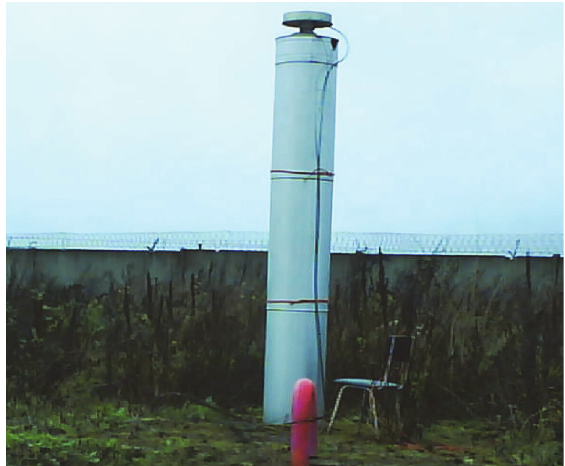
Fig. 2. The GPS station VLNS (Vilnius) (EUREF... 2011)